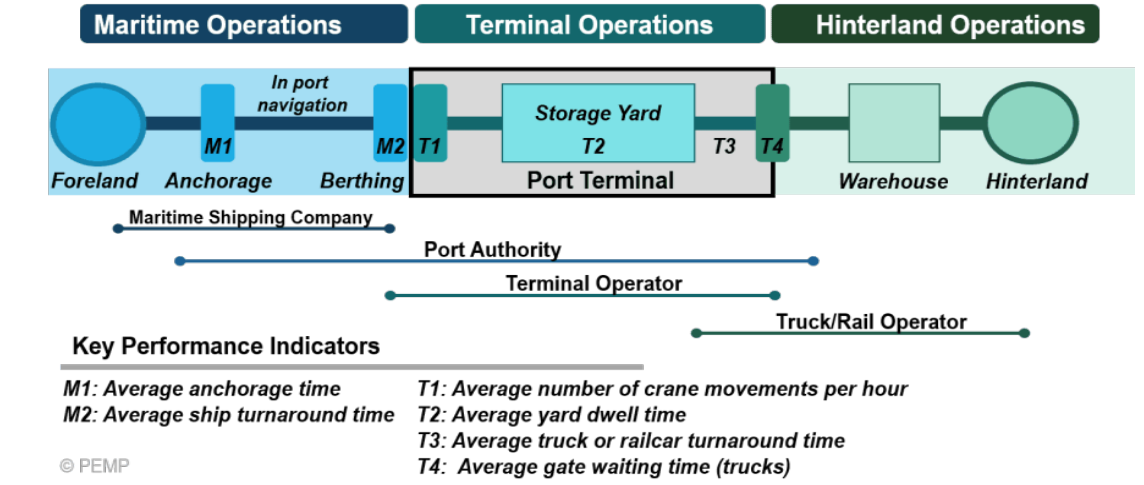
Figure 1. Continuity of container terminal operations.